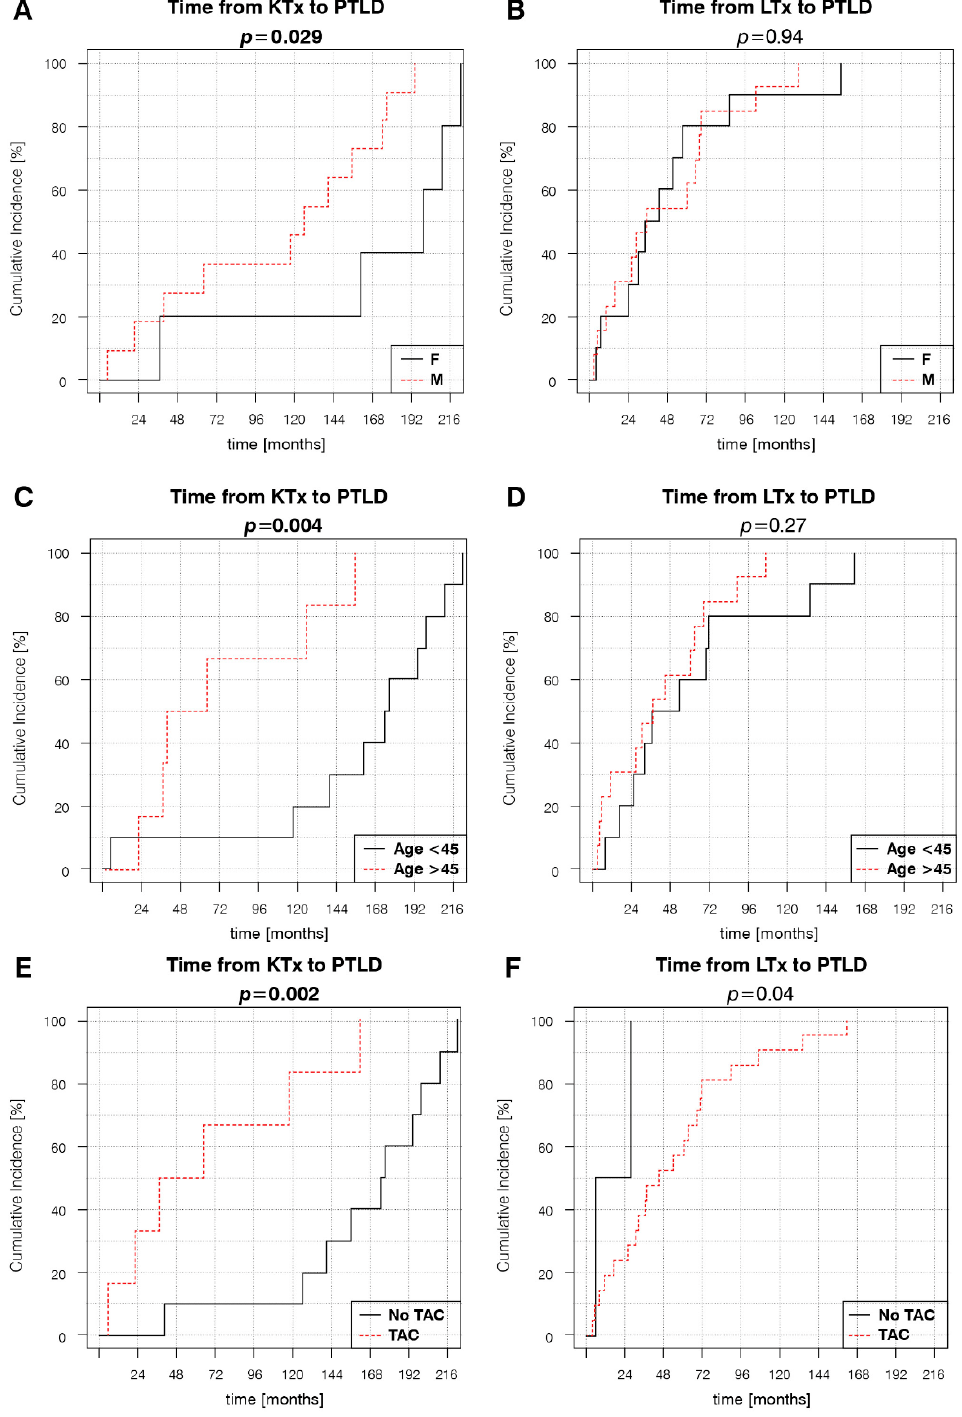
Figure 2. Transplanted organ-dependent effect of different variables on PTLD development: ( A ) KTR sex, ( B ) LTR sex, ( C ) KTR age at transplantation, ( D ) LTR age at transplantation, ( E ) Presence of TAC in KTR IS regimens at PTLD diagnosis, ( F ) Presence of TAC in LTR IS regimens at PTLD diagnosis. p -values represent the log-rank analysis of the Kaplan–Meier estimator curves.